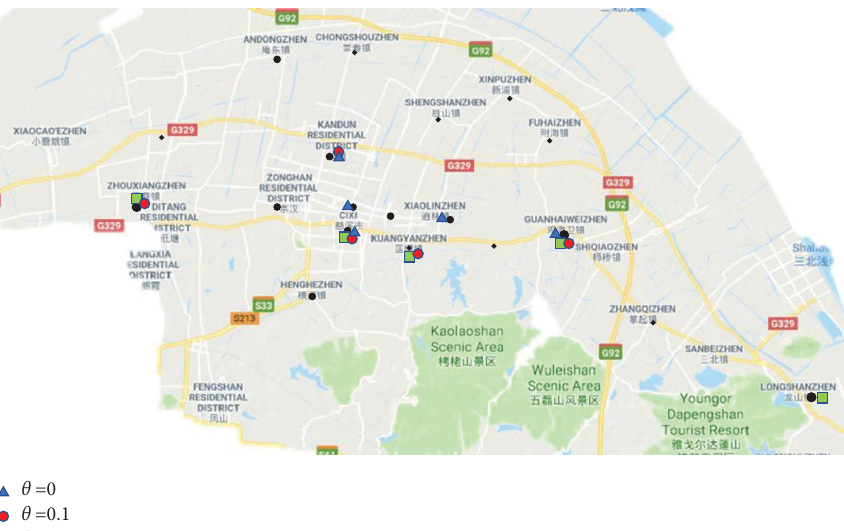
Figure 10: Infuence of θ on location